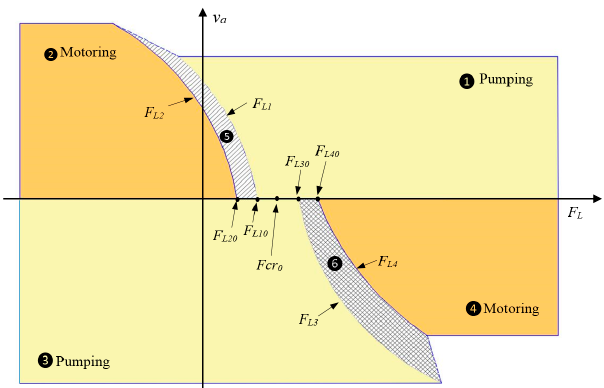
Figure 3. Construction of critical zones (5 and 6) considering the effect of transmission line losses, Coulomb and viscous frictions, and POCVs cracking pressures.